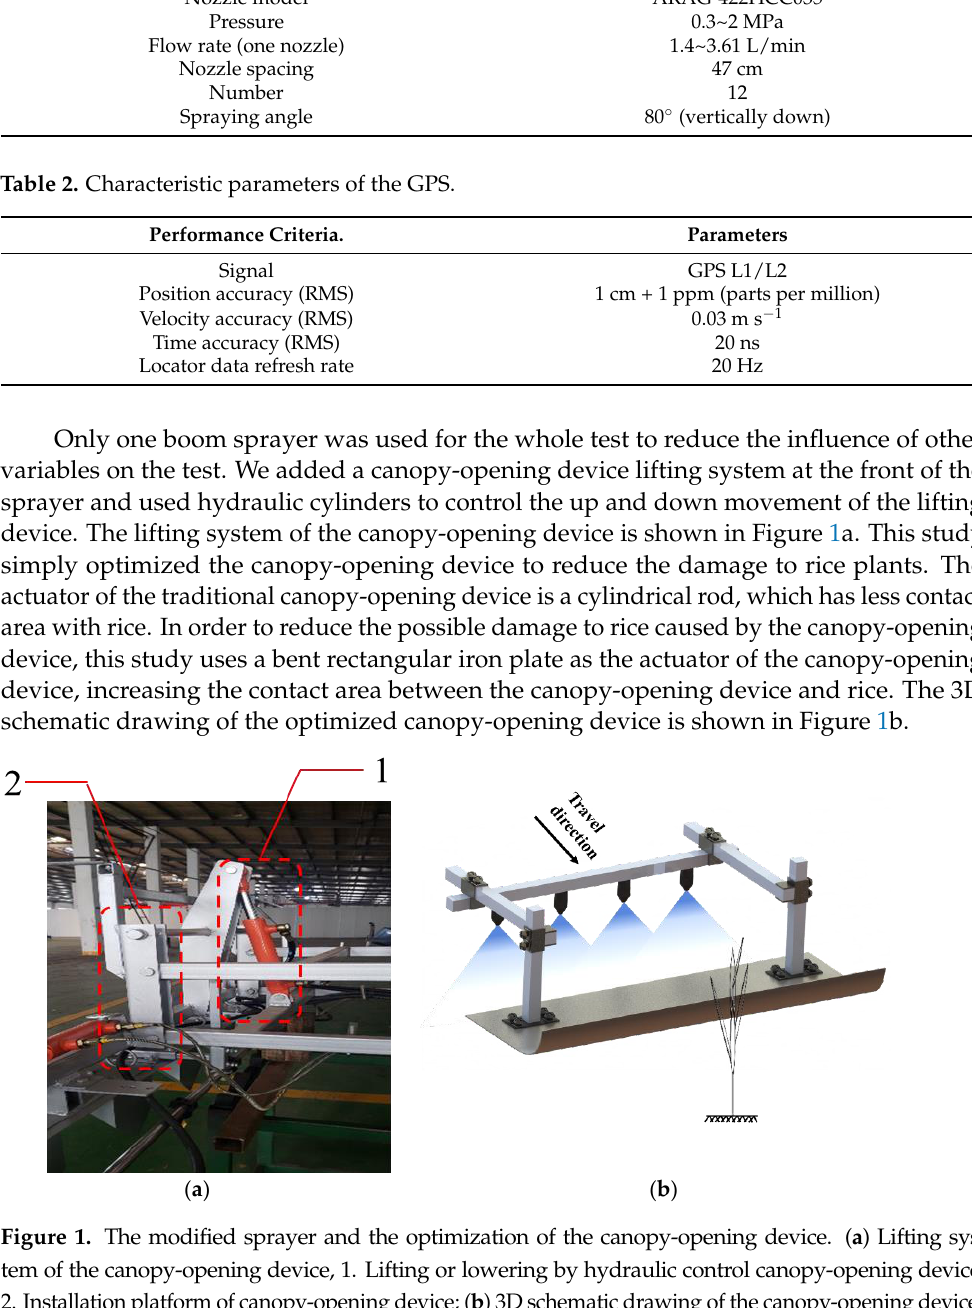
( b ) Figure 2. Spraying platform installation of the canopy-opening device and the canopy-opening di- vider combination device. ( a ) Boom sprayer with the canopy-opening device; ( b ) boom sprayer with the canopy-opening divider combination device. 1. The canopy-opening device; 2. the canopy-open- ing divider combination device; 3. the divider device.